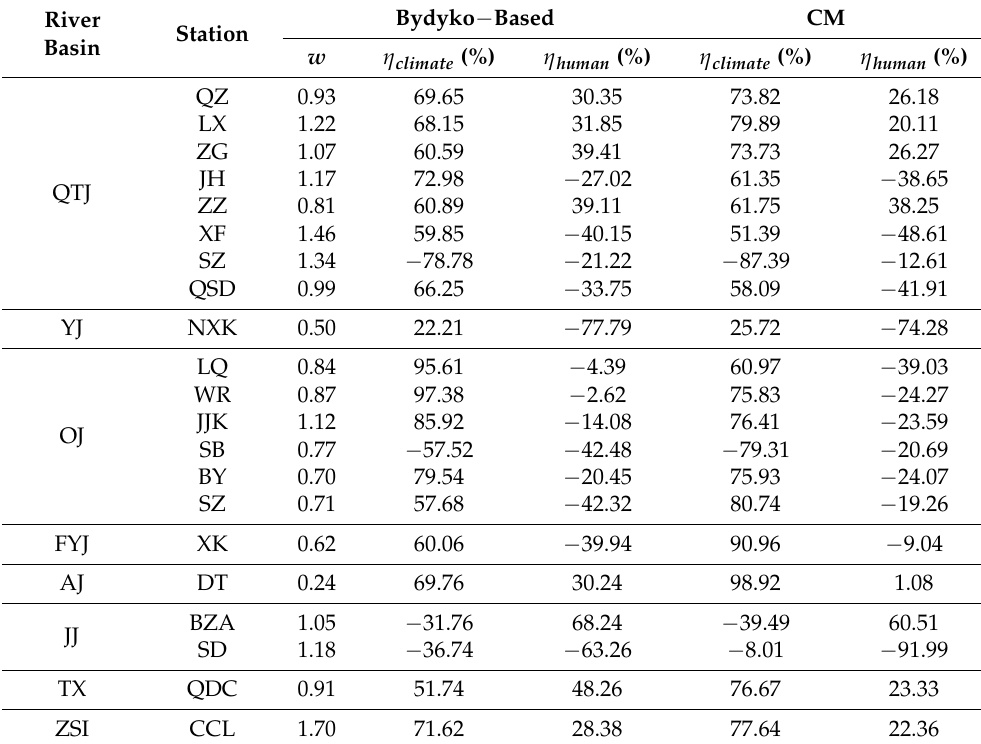
Table 5. The two techniques’ estimations of streamflow variations resulting from climate change and human